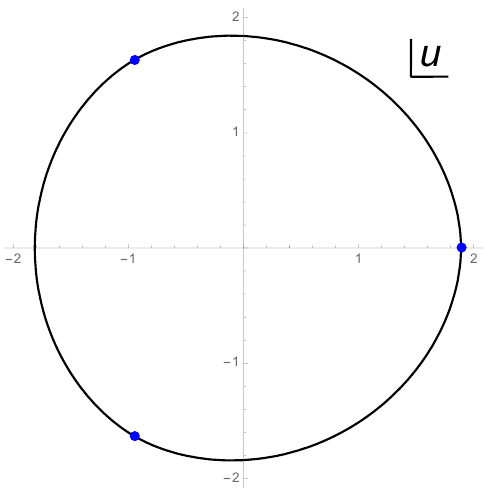
Figure 7. Candidate wall of marginal stability in the u -plane (where v = 0 ) for SU(3) gauge group. The three multi-monopole points are indicated as blue dots. In the u -plane, the wall coincides with the locus where K = 0 , i.e. it coincides with the outermost contour plotted in figure